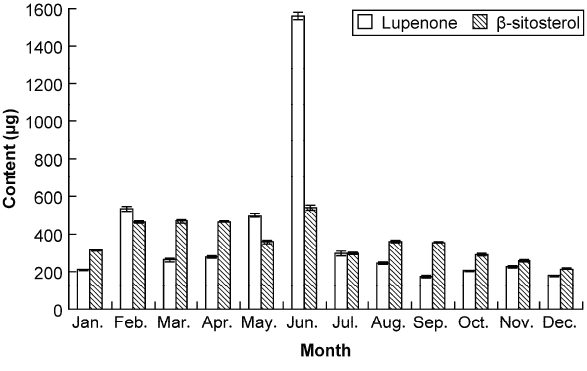
Figure 5. Lupenone and β -sitosterol levels in Rhizoma Musae samples collected over a 12-month